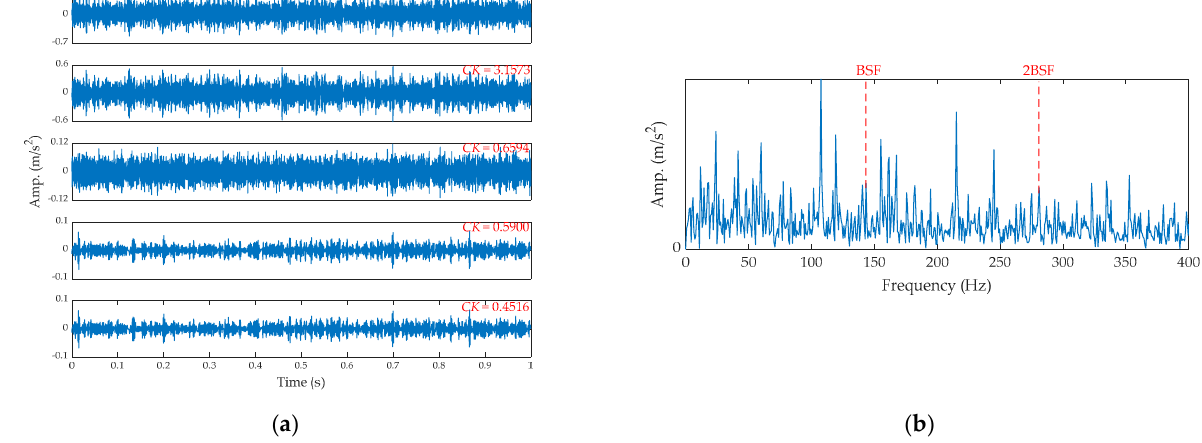
Figure 20. The results by EEMD for the ball fault signal: (a) IMFs and (b) the SES of the first IMF.